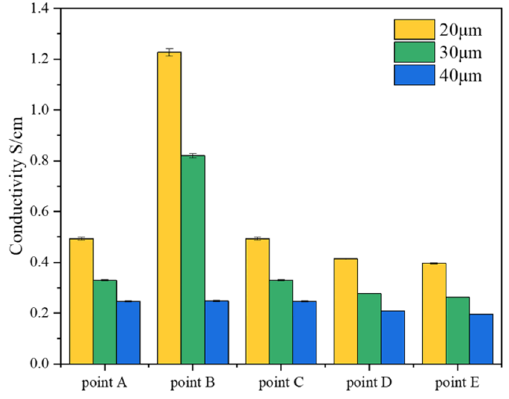
Figure 4. Conductivity of thin film.